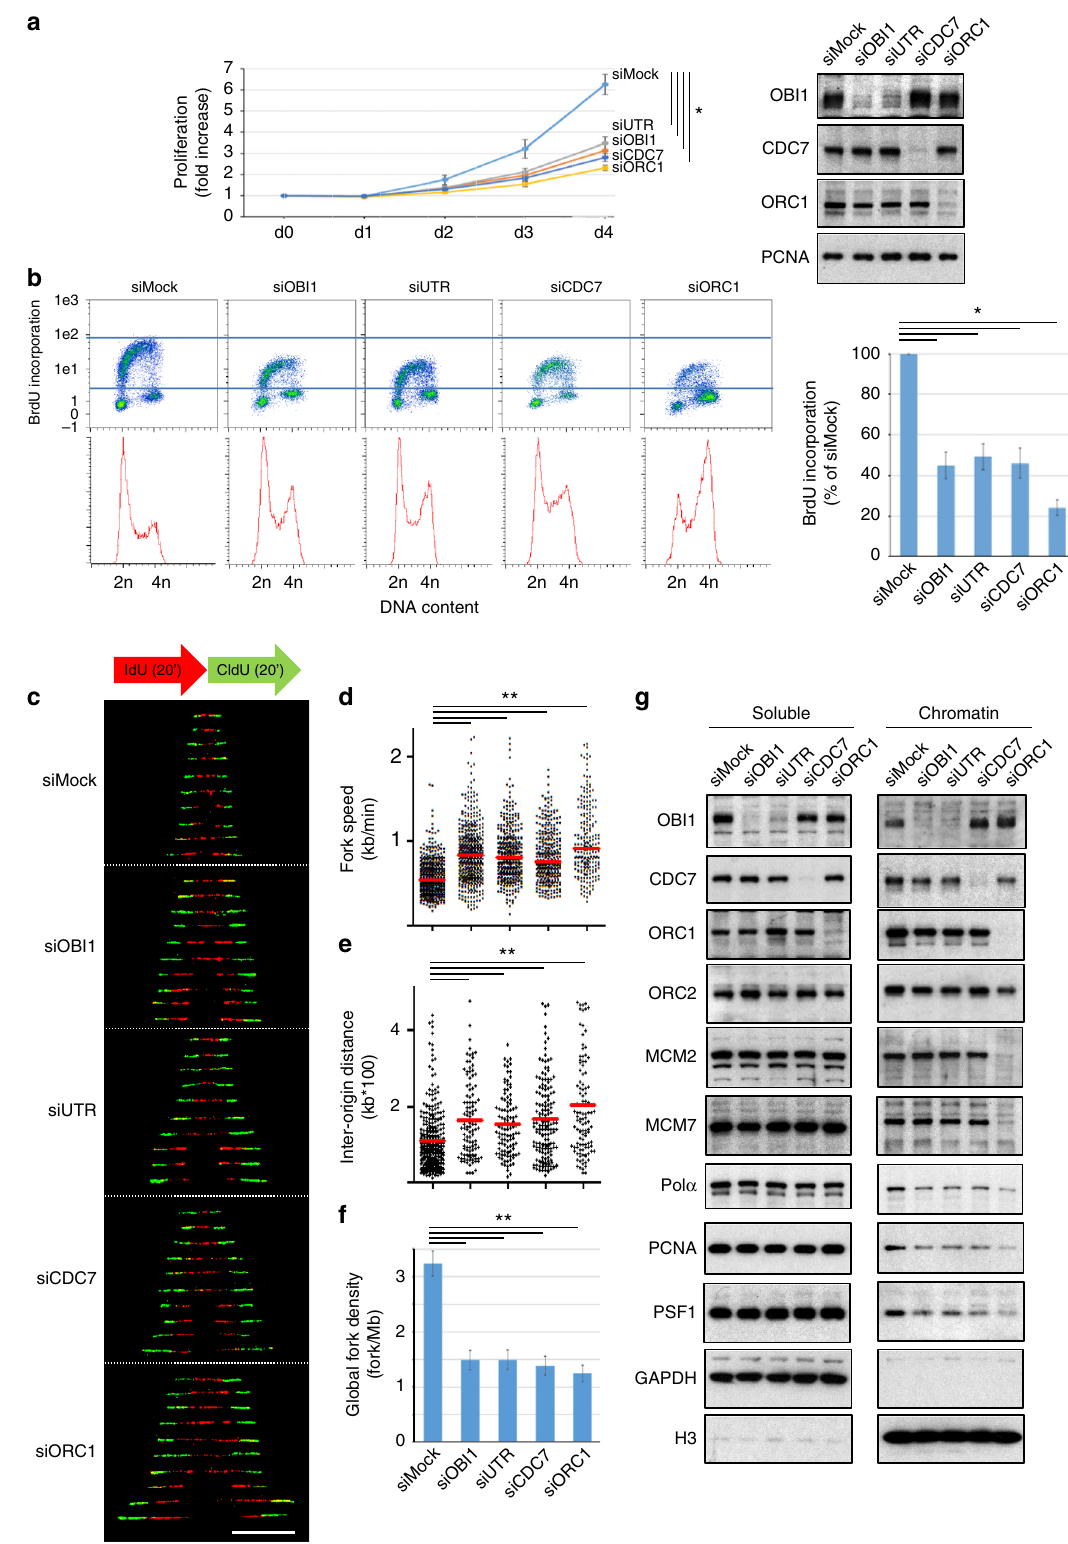
synchronisation in mitosis with nocodazole and release in fresh medium. ORC3/5 ubiquitylation, as observed by the appearance of high molecular weight species, was low in mitotic and early G1-phase cells, whereas it was induced in late G1-/early S-phase, peaked in S-phase, and then decreased toward the end of the cell